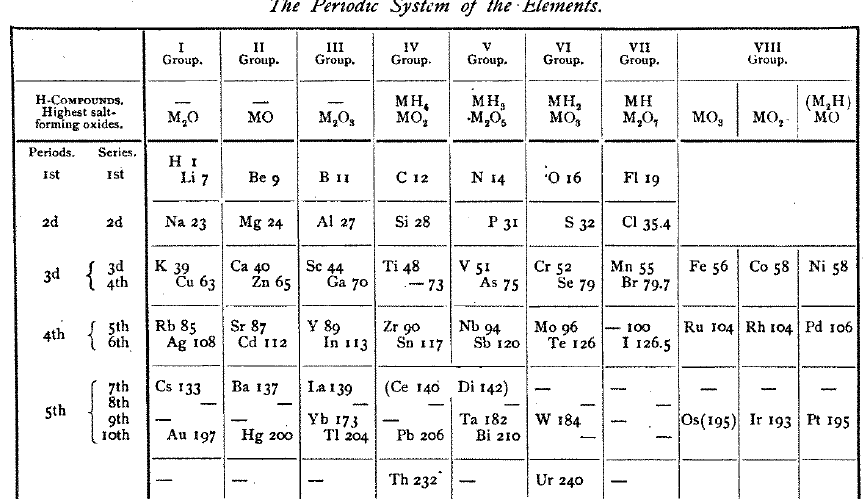
Figure 8. Von Richter’s Periodic Table (1885) which used no A/B sub-group